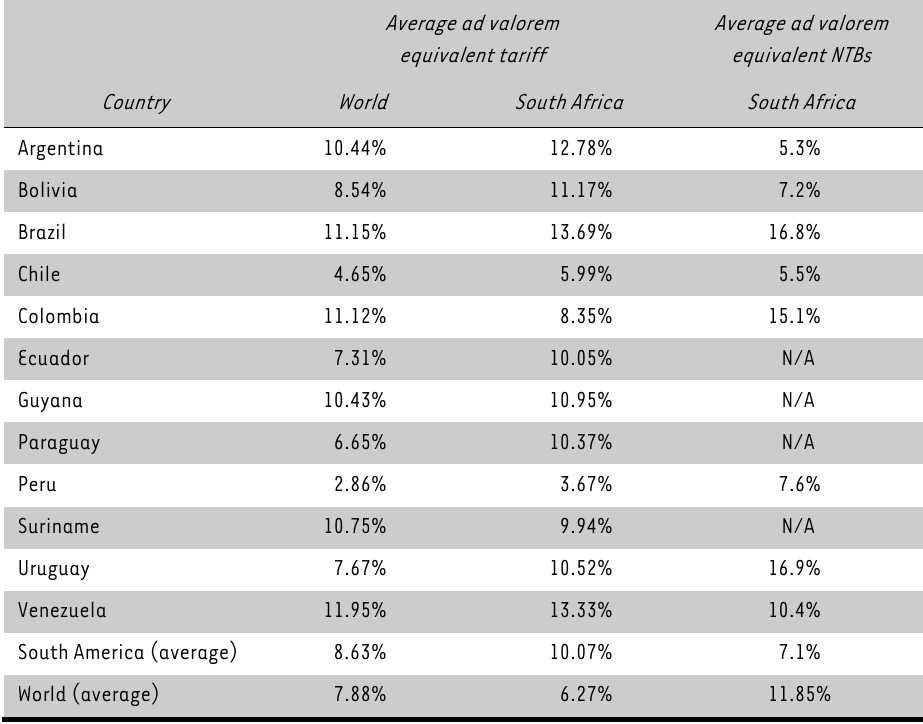
Average tariffs and non-tariff equivalents applied by South American countries to South Africa and the